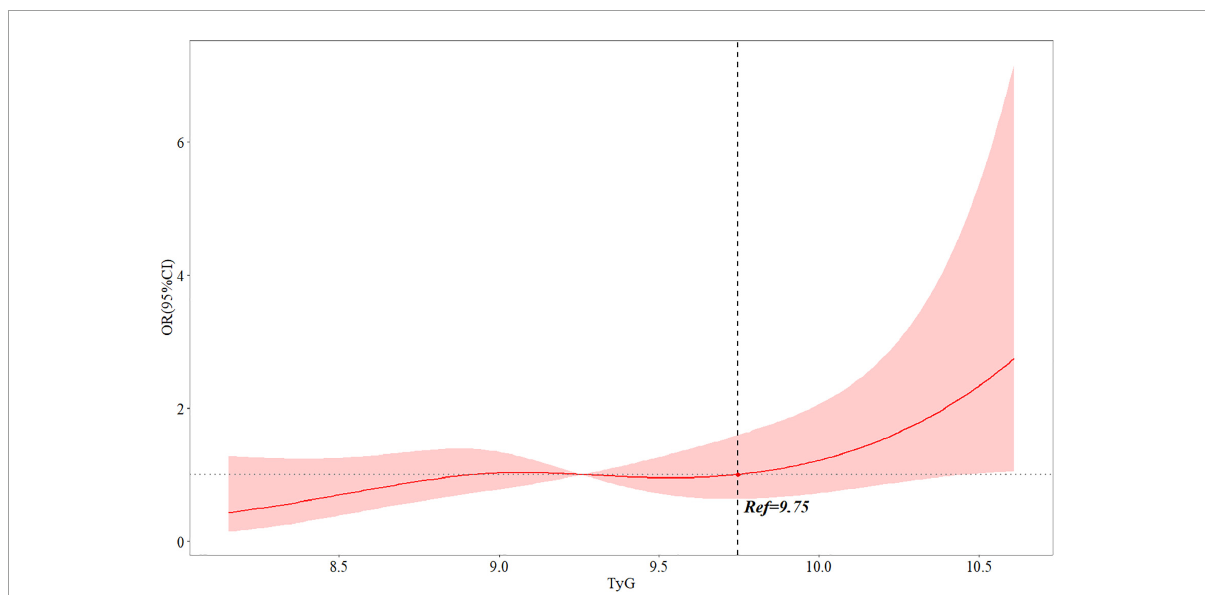
FIGURE1 Multivariable adjusted OR for the risk of post-PCI QFR ≤ 0.92 according to levels of TyG index on a continuous scale. Odds ratios and 95% CIs derived from restricted cubic spline regression, with knots placed at the 5th, 35th, 65th, and 95th percentiles of the distribution of TyG index. The reference point for TyG index is located at OR = 1. Ref represents the level of TyG index at increased risk of post-PCI QFR ≤ 0.92. Analyses were adjusted for age, sex, BMI, LVEF, smoking, hypertension, DM, previous myocardial infarction, creatine, culprit vessel, length of stents, in-stent minimal lumen diameter and in-stent diameter stenosis. OR, odds ratio; QFR, quantitative flow ratio; TyG, triglyceride-glucose; BMI, body mass index; LVEF, left ventricular ejection fraction; DM, diabetes mellitus; PCI, percutaneous coronary intervention; CI: confidence